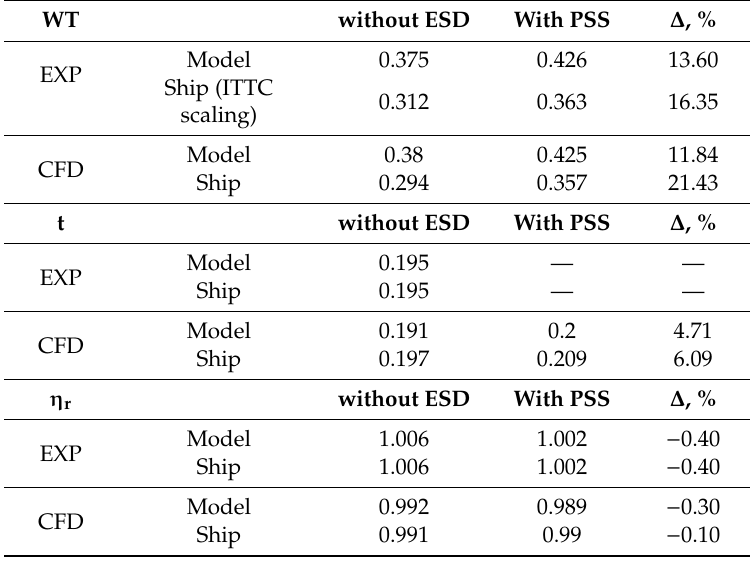
Table 9. Relative changes in propeller RPM, shaft delivered power, and propulsive e ffi ciency due to the installation of PSS. (PSS-Var-5, full scale). WT without ESD With PSS ∆ , % Model 0.375 0.426 13.60 EXP scaling)